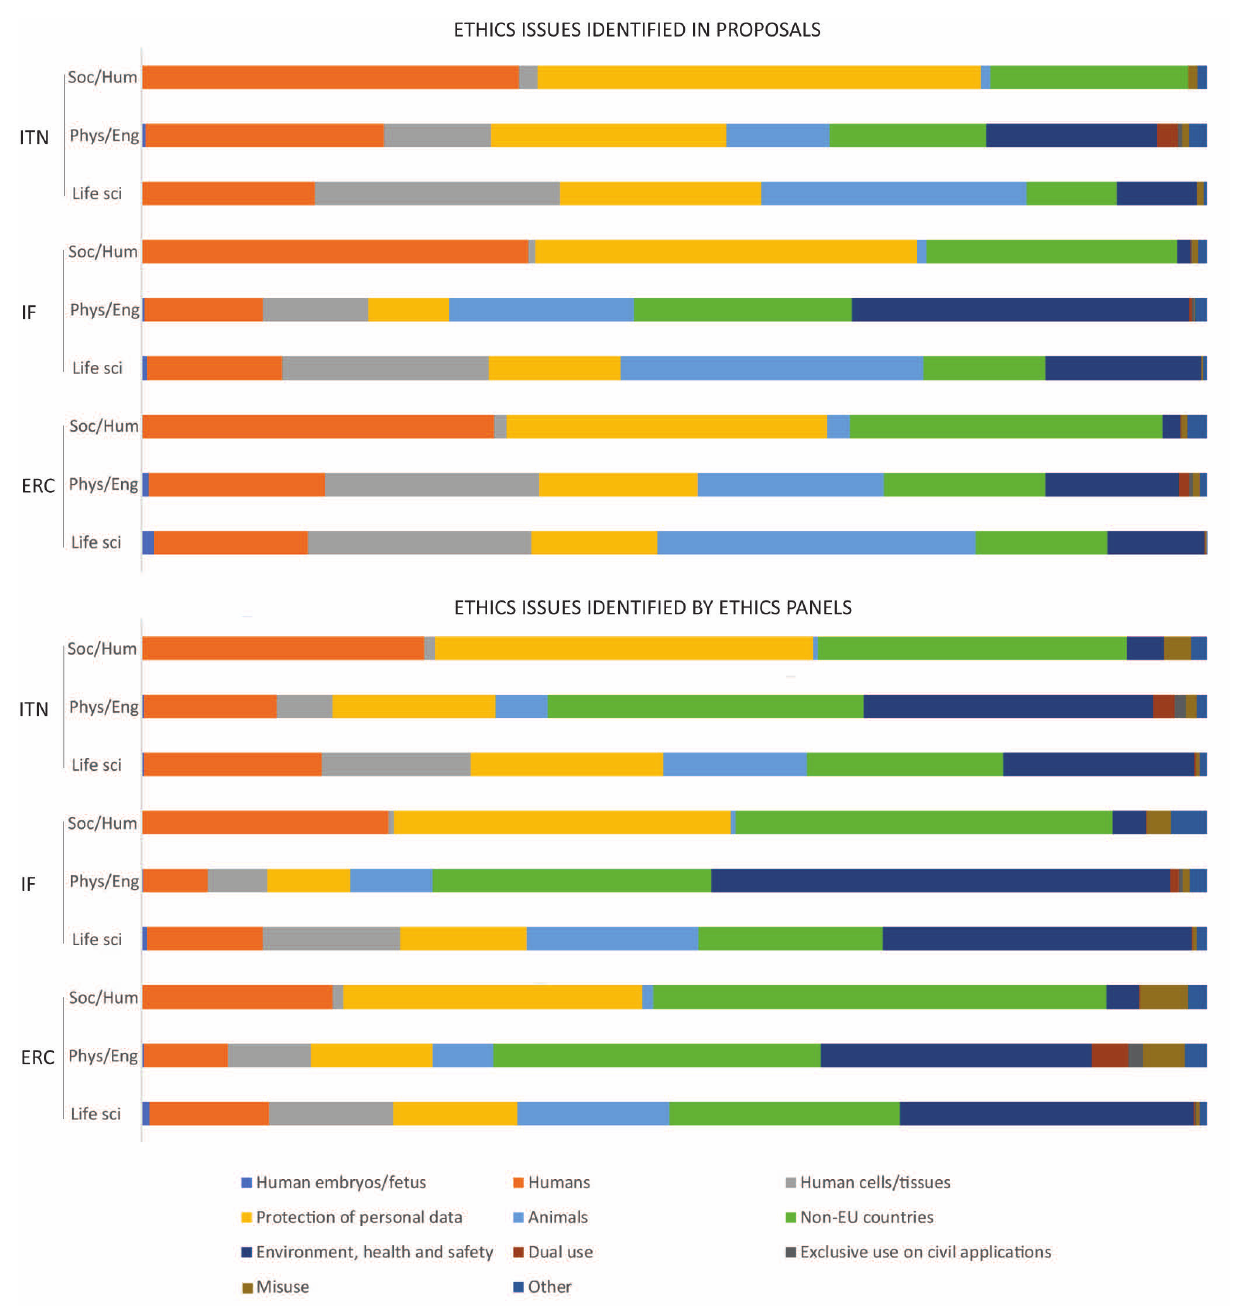
Figure 5. Distribution of ethics issues categories identified by proposal applicants and ethics experts, by research domain. ITN – Innovative Training Networks, IF – Individual Fellowships, ERC – European Research Council grants. The data are from years available in the SEP tool of the European Commission. Soc/Hum – Social Sciences and Humanities, Phys/Eng – Physical Sciences and Engineering, Life sci – Life Sciences.